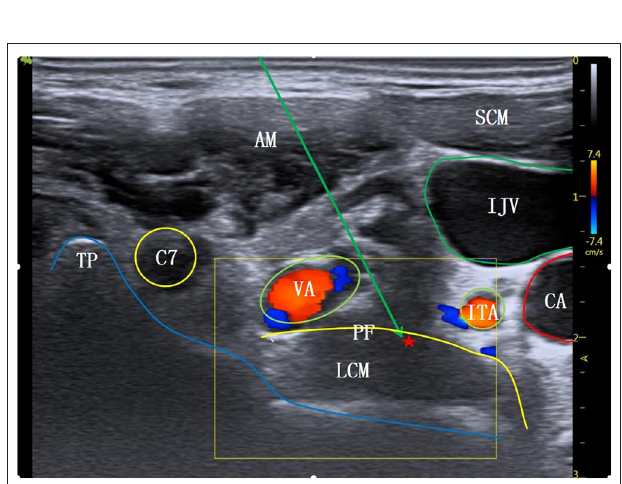
FIGURE 3 | The level at C7 transverse process. AM, anterior scalene muscle; SCM, sternocleidomastoid muscle; C7, the 7th cervical nerve root; TP, transverse process; VA, vertebral artery; ITA, inferior thyroid artery; PF, anterior vertebral fascia; LCM, long neck muscle; ⋆ Indicates stellate ganglion block area; ց Indicates simulated puncture path; IJV, internal jugular vein; CA, carotid